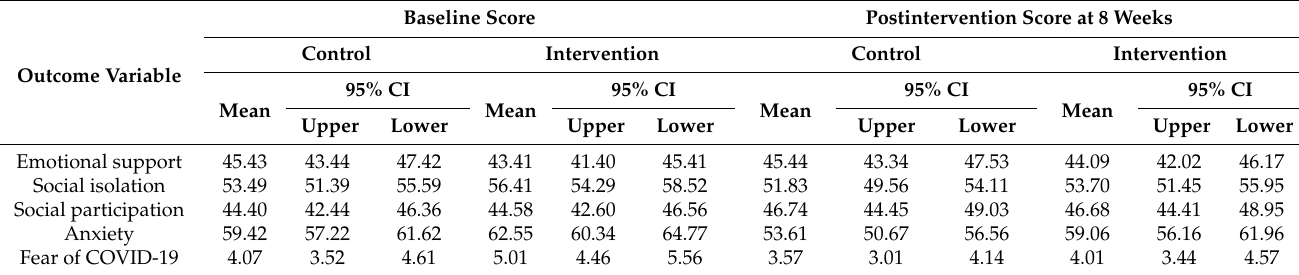
Table 3. Mean scores for the outcome measures of the intention-to-treat analysis ( n = 135). Baseline Score Postintervention Score at 8 Weeks Control Intervention Control Outcome Variable